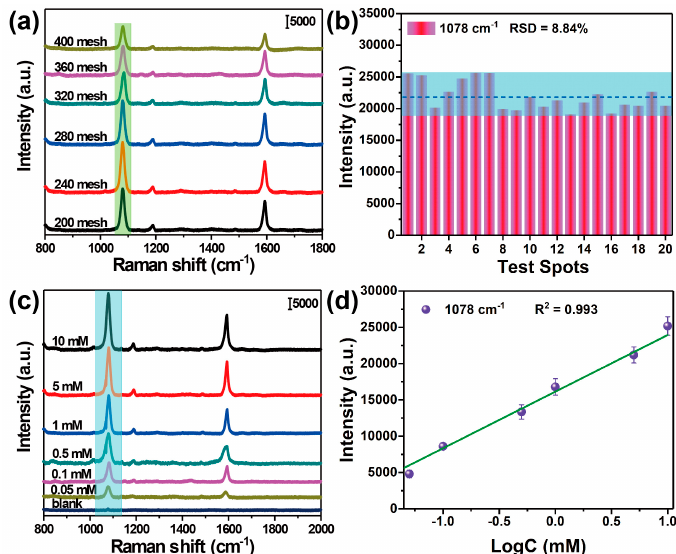
Figure 7. ( a ) EDS of Ag-coated sandpaper and the corresponding local elemental mapping of ( b ) Ag; ( c ) C; and ( d ) Si.